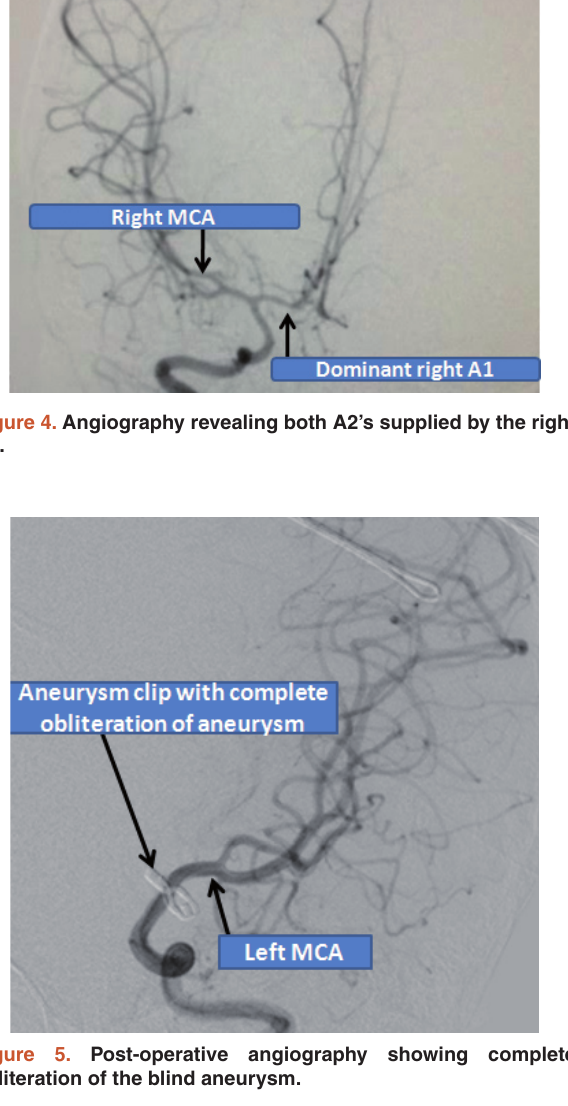
Figure 6. Angiography showing both A2’s supplied from the right